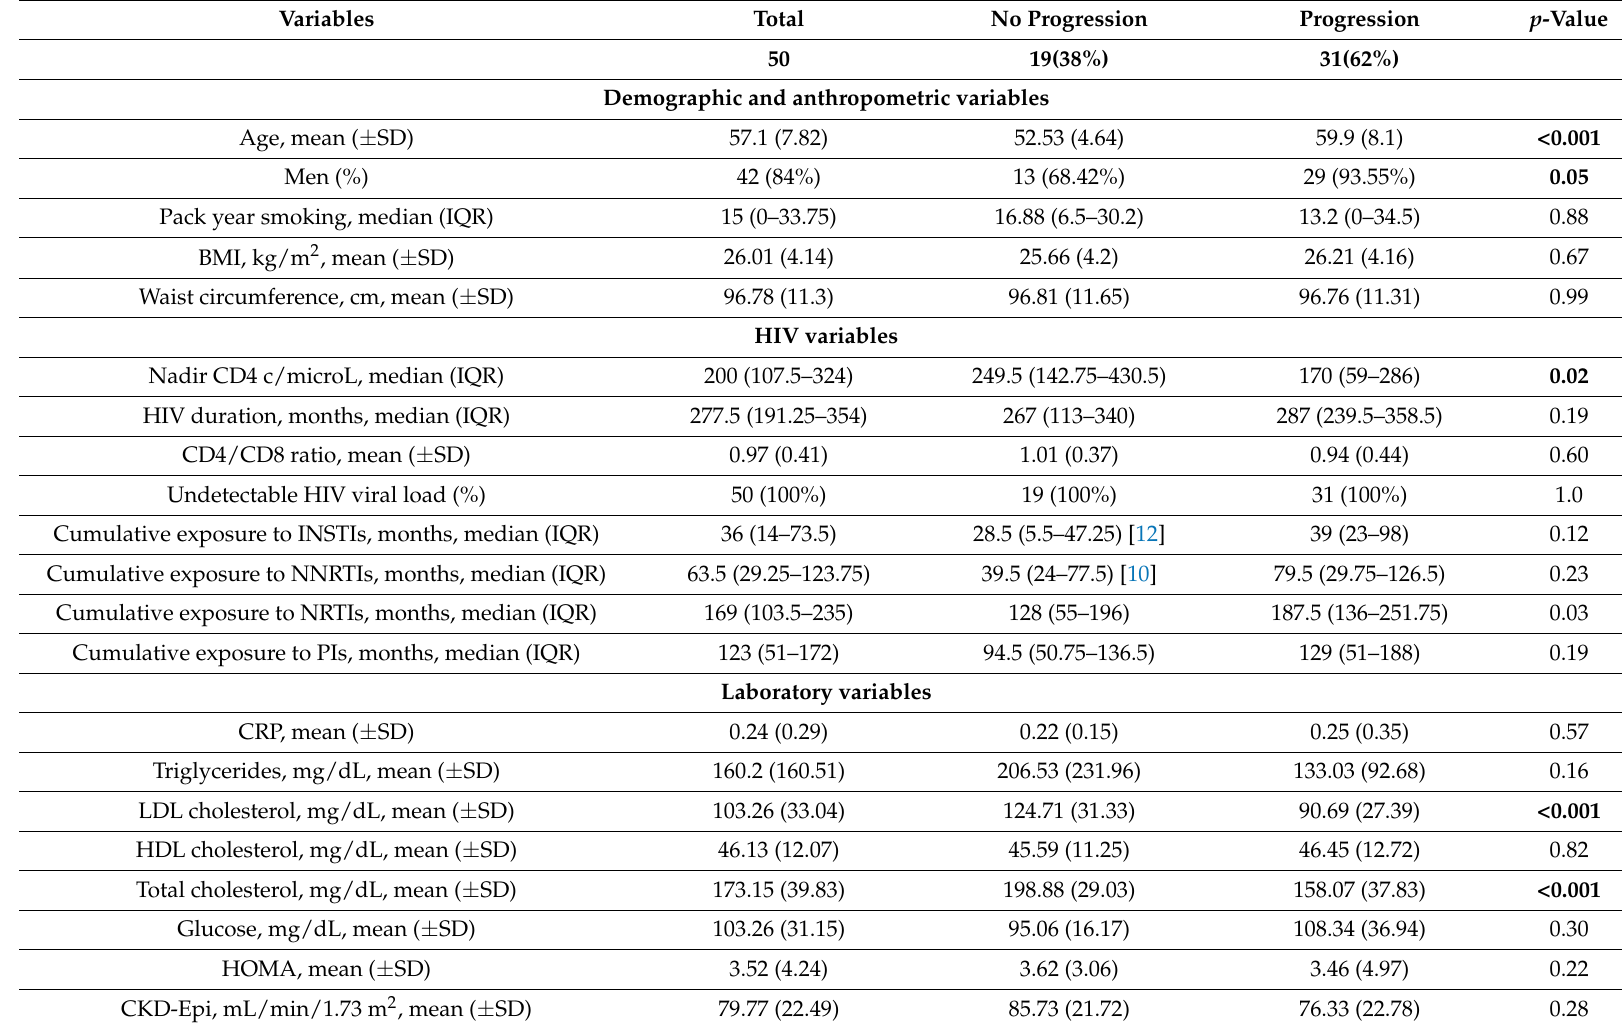
Table 1. Patients’ clinical